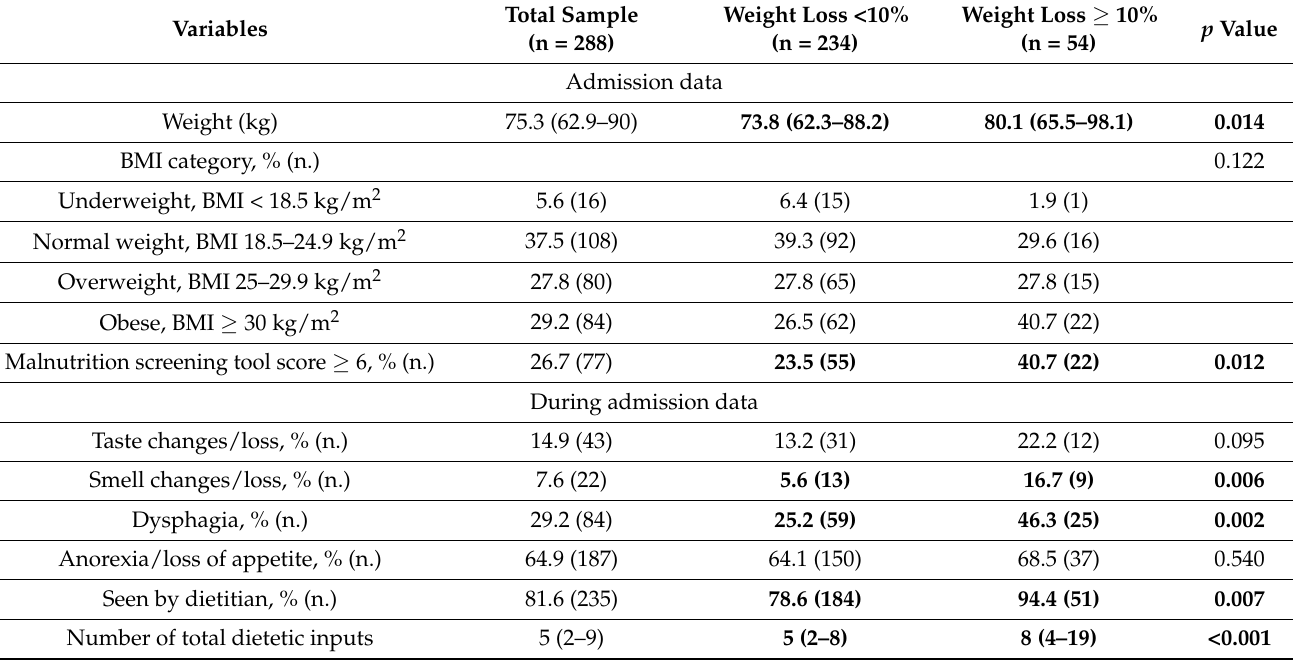
Table 2. Nutrition-related characteristics of the analysed sample (n = 288) and comparisons